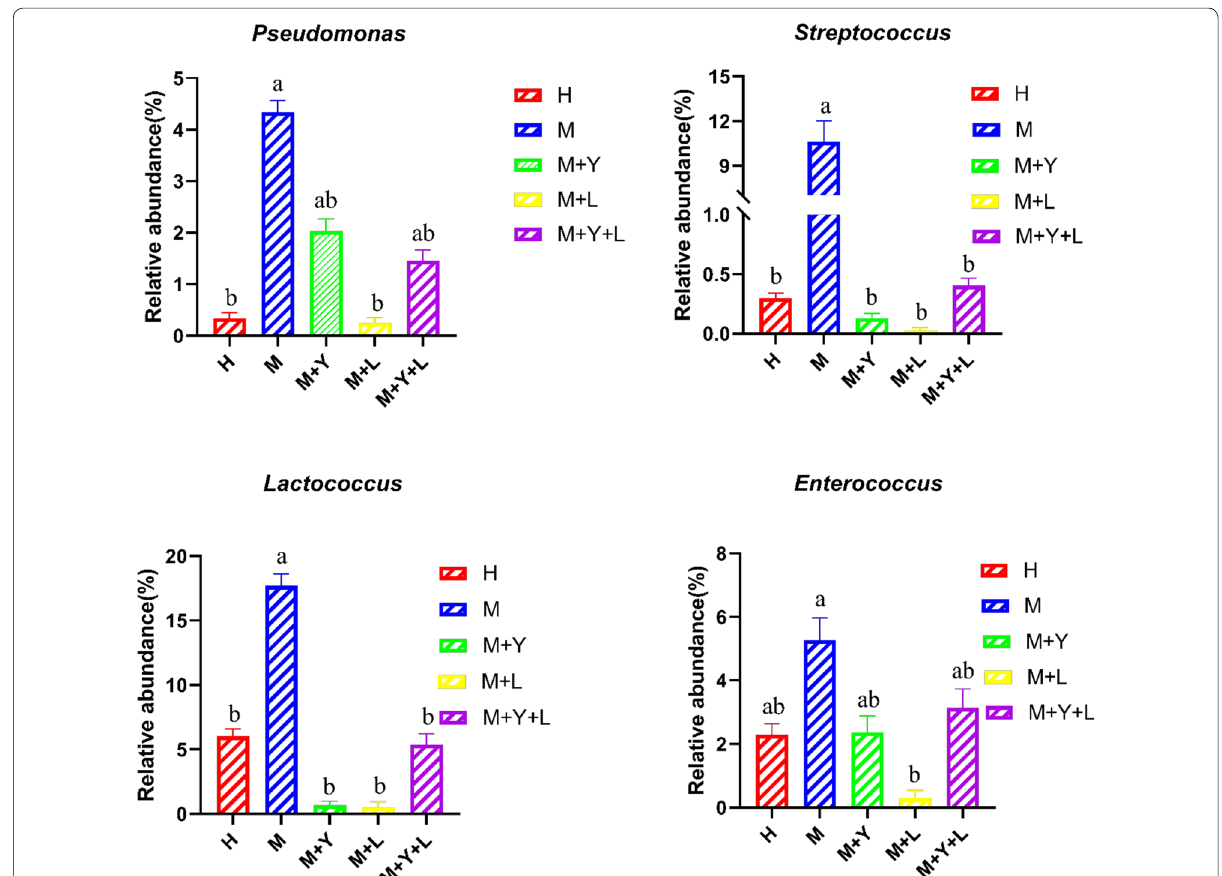
Fig. 6 The relative abundance (%) of Pseudomonas , Streptococcus , Lactococcus and Enterococcus at genus